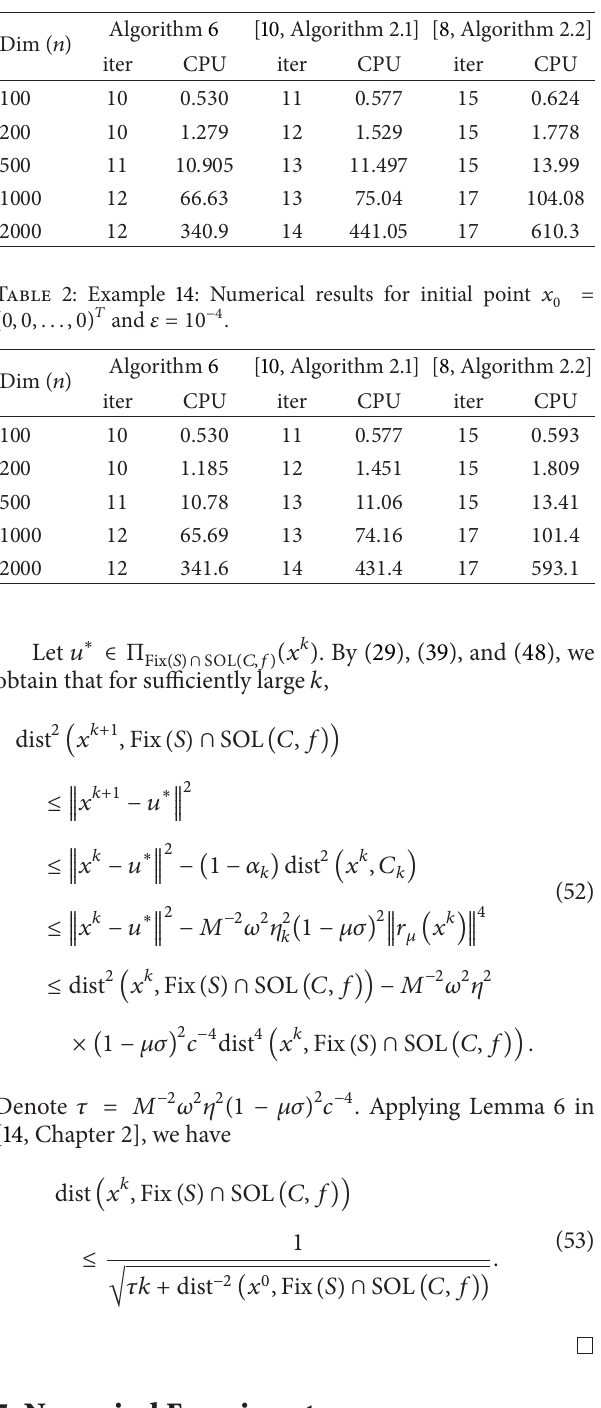
Table 1: Example 14: Numerical results for initial point 𝑥 0 = (1,1,...,1) 𝑇 and 𝜀 = 10 −4 . Algorithm 6 Dim ( 𝑛 )